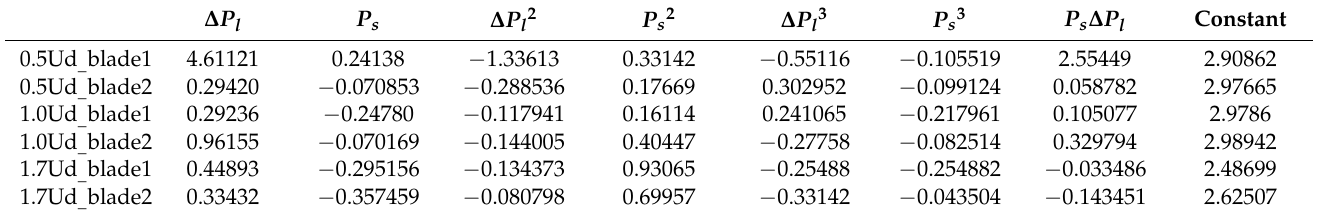
Table 1. Calculated coefficients under different cruising speeds.